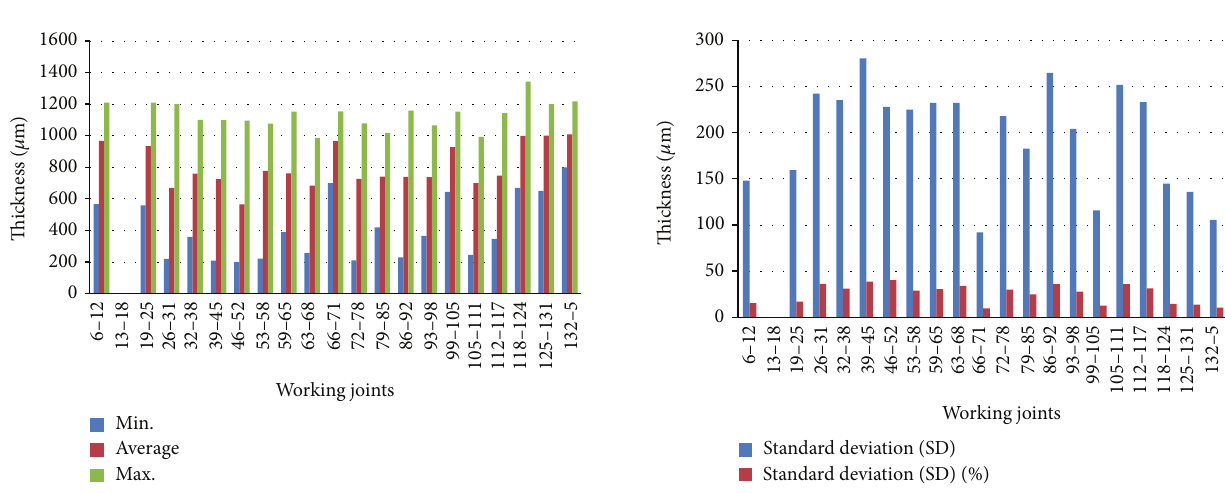
Figure 7: Standard deviation of reinforcement of external shell.